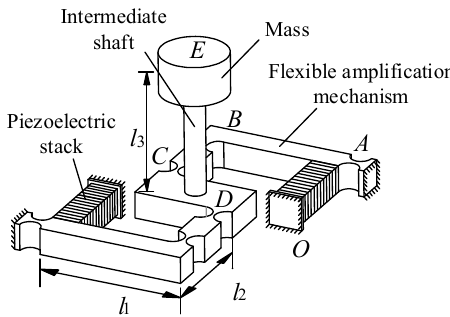
Figure 4. Simplified model of piezoelectric system for free vibration.